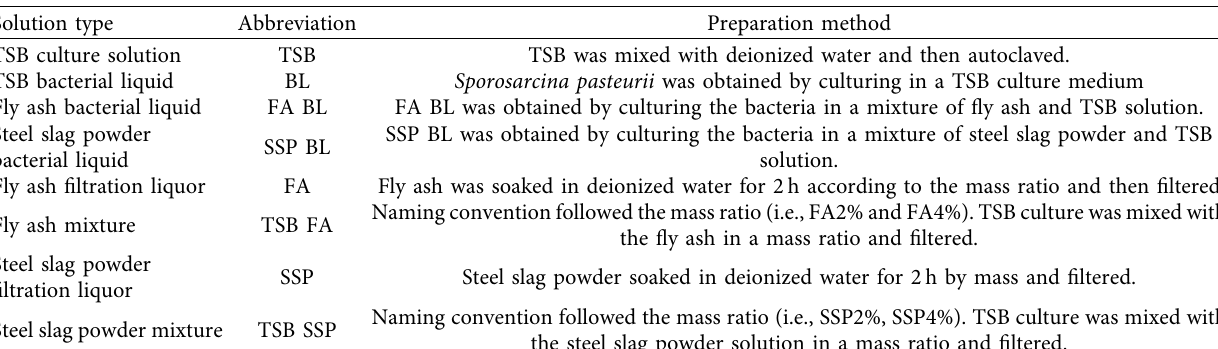
Table 5: Names of the solutions and bacterial